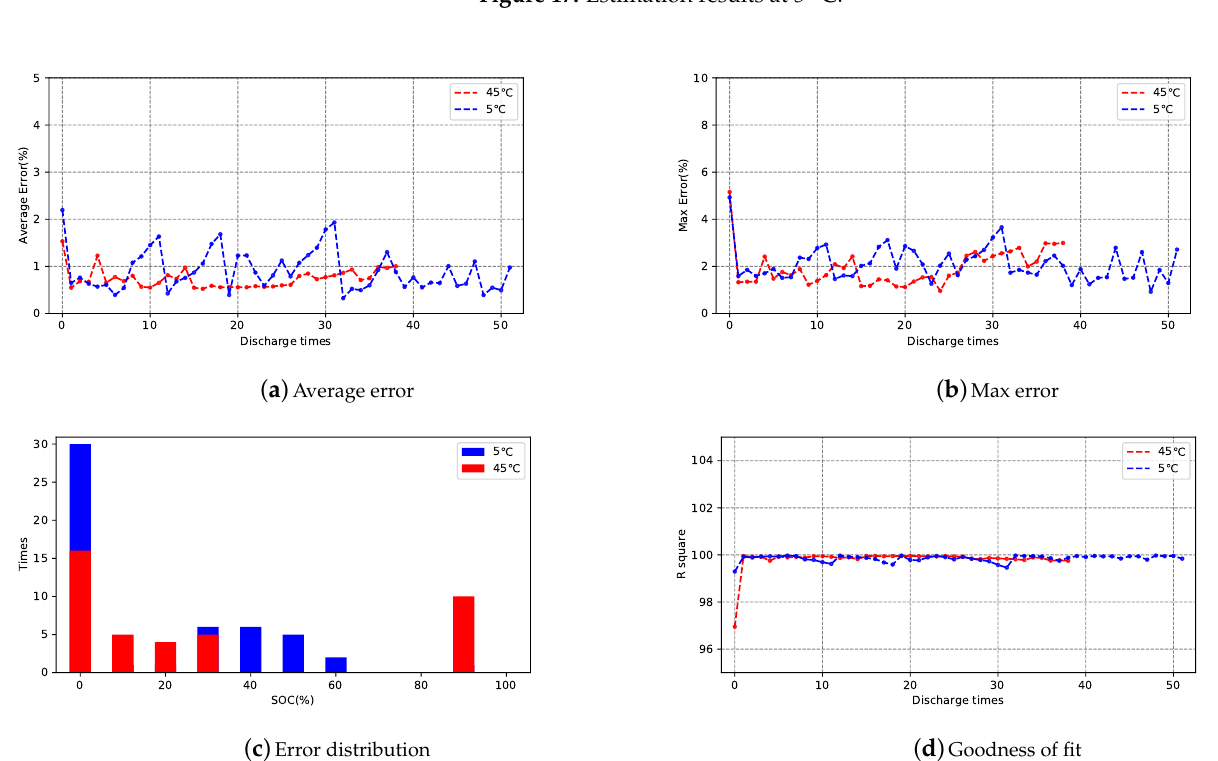
Figure 18. Estimation results of two working